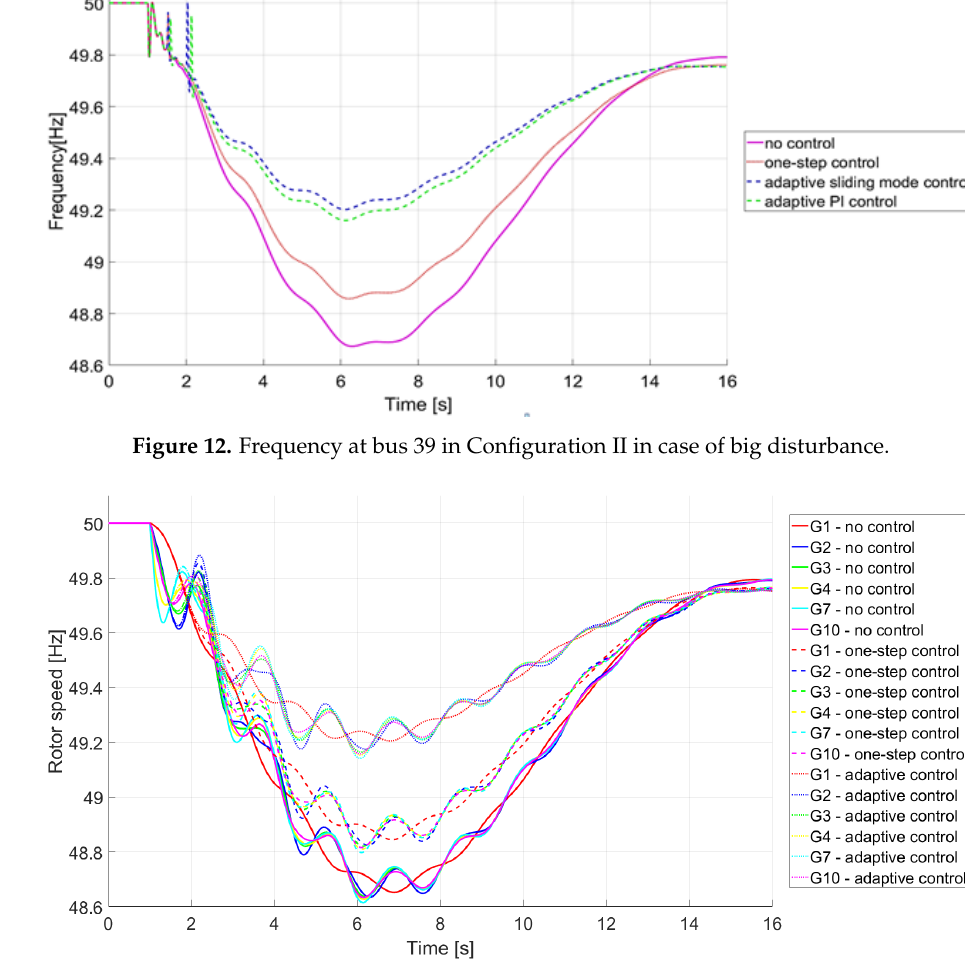
Figure 13. Generators’ rotor speed in Configuration II in case of big